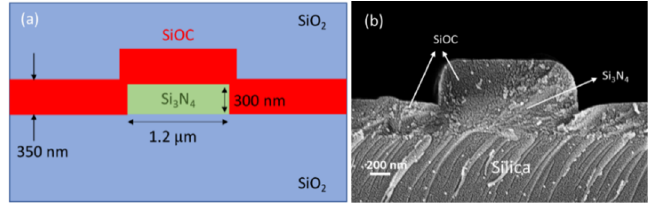
Figure 1. ( a ) Geometry scheme and ( b ) SEM micrograph of SiOC-coated SiN waveguide.